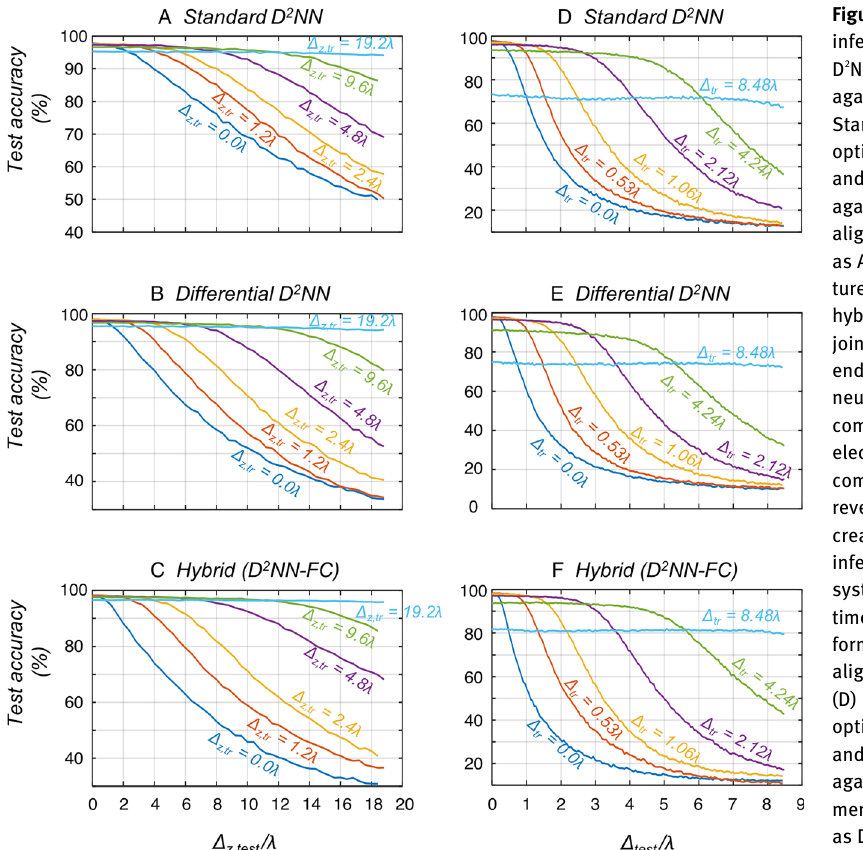
Figure 2: The sensitivity of the blind inference accuracies of different types of D 2 NN-based object classi fi cation